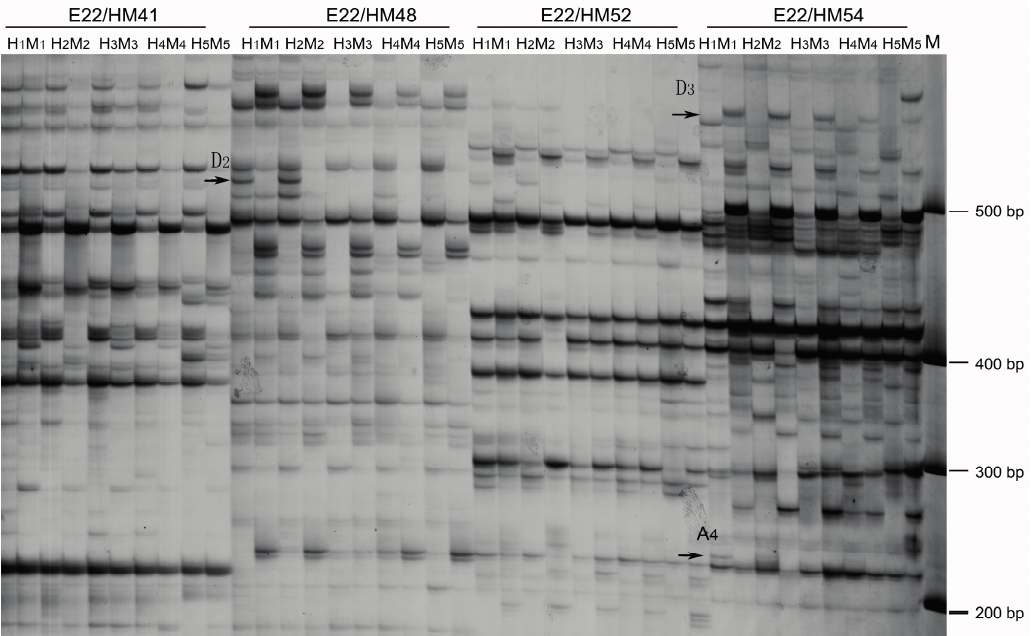
Figure 4. Changes of DNA methylation pattern in MMS-treated PaWB plantlets. H1 and M1 : band digested by Eco RI/ Hpa II (H) and Eco RI/ Msp I (M) in PaWB plantlets; H2 and M2 : band digested by H and M in plantlets with 15 mg·L − 1 MMS treatment; H3 and M3 : band digested by H and M in plantlets with 30 mg·L − 1 MMS treatment; H4 and M4 : band digested by H and M in plantlets with 45 mg·L − 1 MMS treatment; H5 and M5 : band digested by H and M in HP. E22/HM41–E22/HMx: primer combination; M : marker. The arrows indicated 4 lanes of part of the methylation patterns variations only between PaWB plantlets and the ones with 15 mg·L − 1 MMS treatment (H1, M1, H2, M2). D3, A4 and D2 indicated part of the methylation patterns variations. The band of D3, A4 and D2 were (0,1,0,1), (1,0,0,0) and (1,0,1,0),